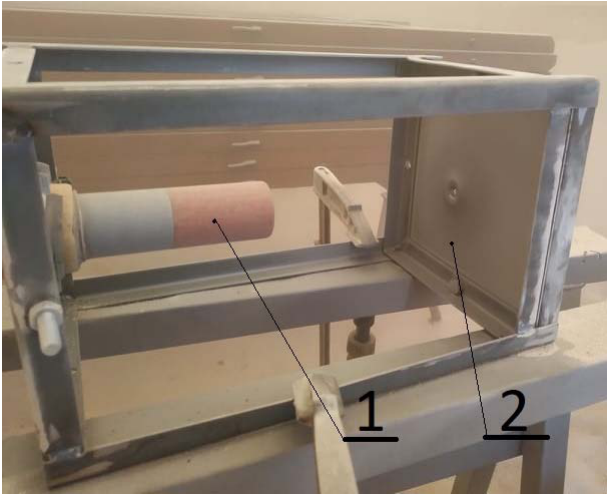
Figure 1. Test stand for erosion tests: ( 1 ) Nozzle; ( 2 ) tested sheet. Table 1. Time of the erosion tests performed for individual steel grades.